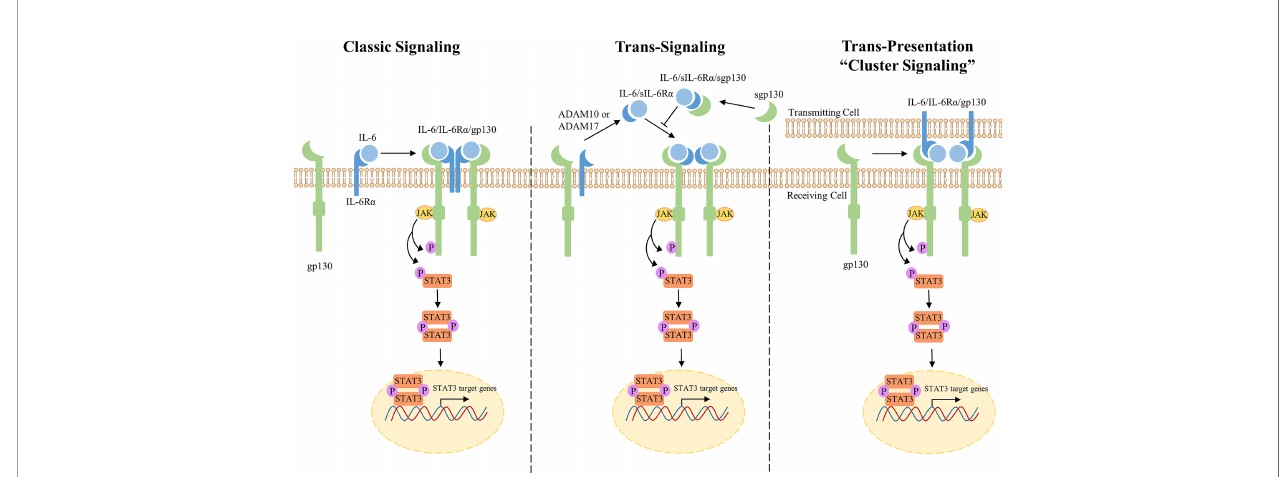
FIGURE 1 | Overview of IL-6/JAK/STAT3 Classic, Trans-signaling, and Trans-presentation. Classic Signaling (left) occurs when IL-6 binds membrane-bound IL-6R a leading to the subsequent formation of a trimeric receptor complex with signal-transducing subunit, gp130. Two trimeric IL-6/IL-6R a /gp130 complexes bind through the D1 domain of gp130 to form a hexameric receptor complex for intracellular signaling through the JAK/STAT3 pathway. JAKs are recruited to the membrane and phosphorylate the cytoplasmic tail of gp130 and STAT3. pSTAT3 homodimerizes and translocates into the nucleus for activation of transcription. Trans-signaling (middle) occurs when IL-6R a presents in a soluble form through mRNA alternative splicing or proteolysis by ADAM10/17. IL-6 binds sIL-6R a to form a hexameric receptor complex through membrane-bound gp130 for signal transduction. Sgp130 antagonizes IL-6 signaling through sequestration of IL-6/sIL-6R a . Trans- presentation (right), or “ cluster signaling, ” occurs between two different cells. A gp130 receptor complex on a receiving cell responds to a IL-6/IL-6R a complex on a transmitting cell to induce downstream STAT3